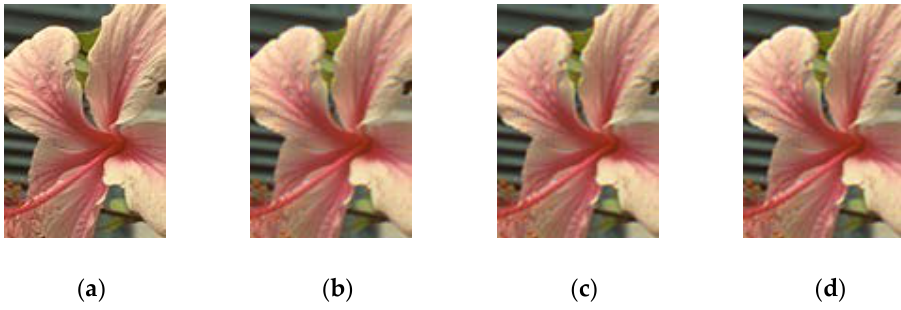
Figure 8. A partial enlargement of Figure 7g: ( a ) original image, ( b ) bilinear interpolation, ( c ) APIDCT interpolation, and ( d ) APDST interpolation.